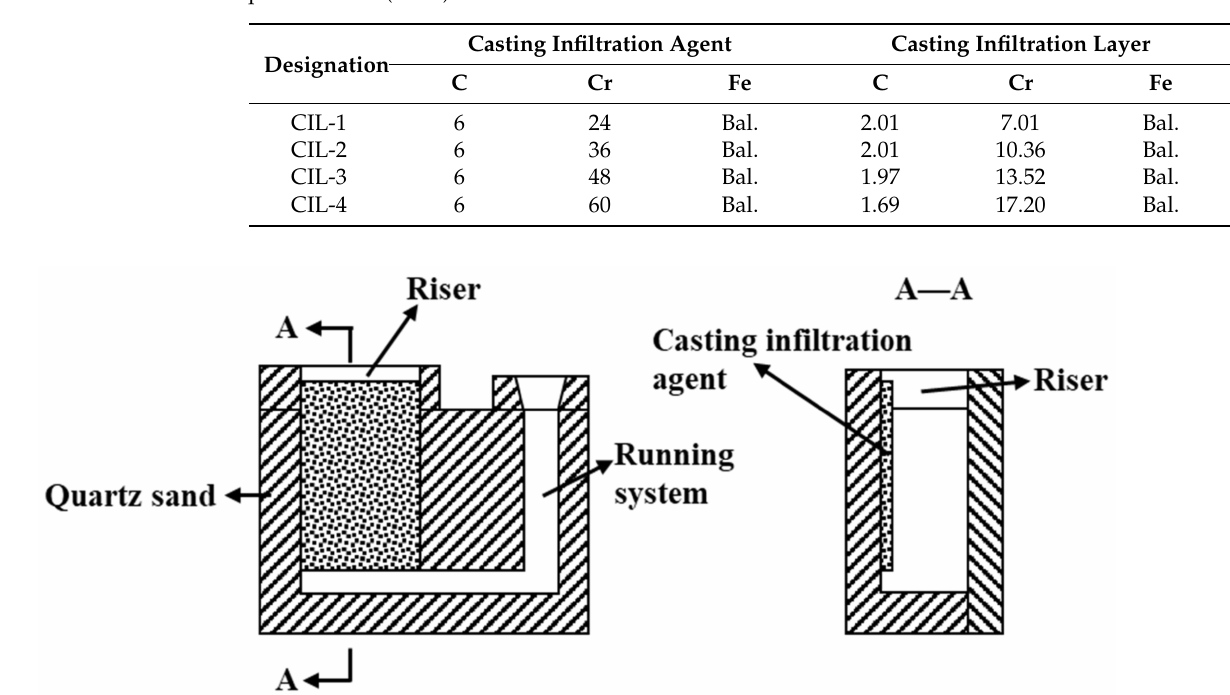
Table 1. Alloy compositions of casting infiltration agents and casting infiltration layers used in the present work (wt.%).